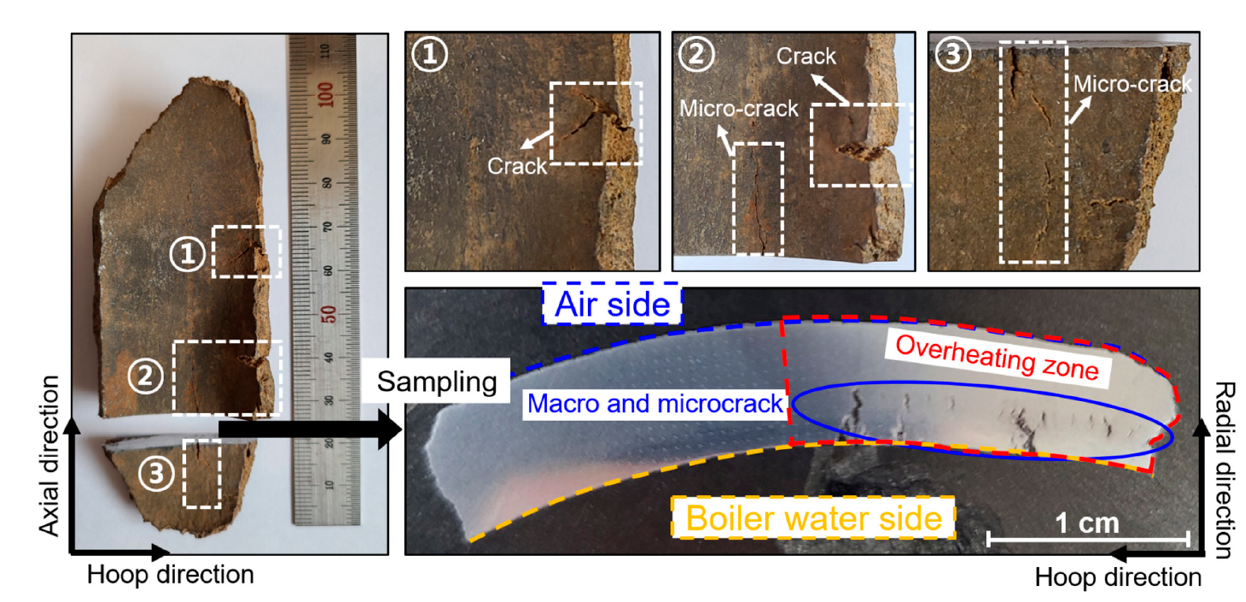
Figure 2. Visual inspection images for the fractured part shown in a schematic of the water wall tube in Figure 1.